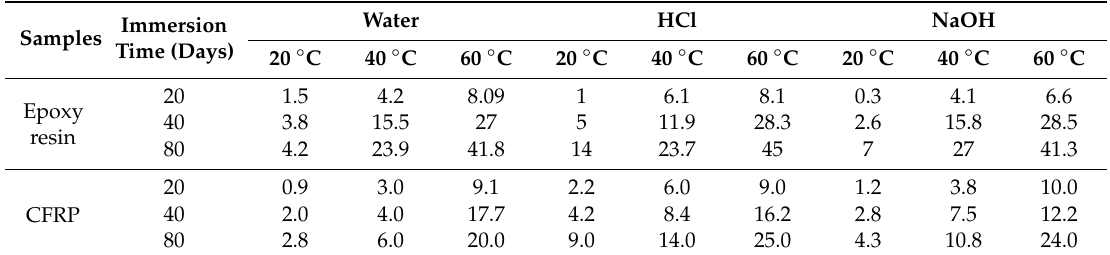
Tensile strength reduction (%) of the epoxy and CFRP composites at di ff erent immersion conditions.